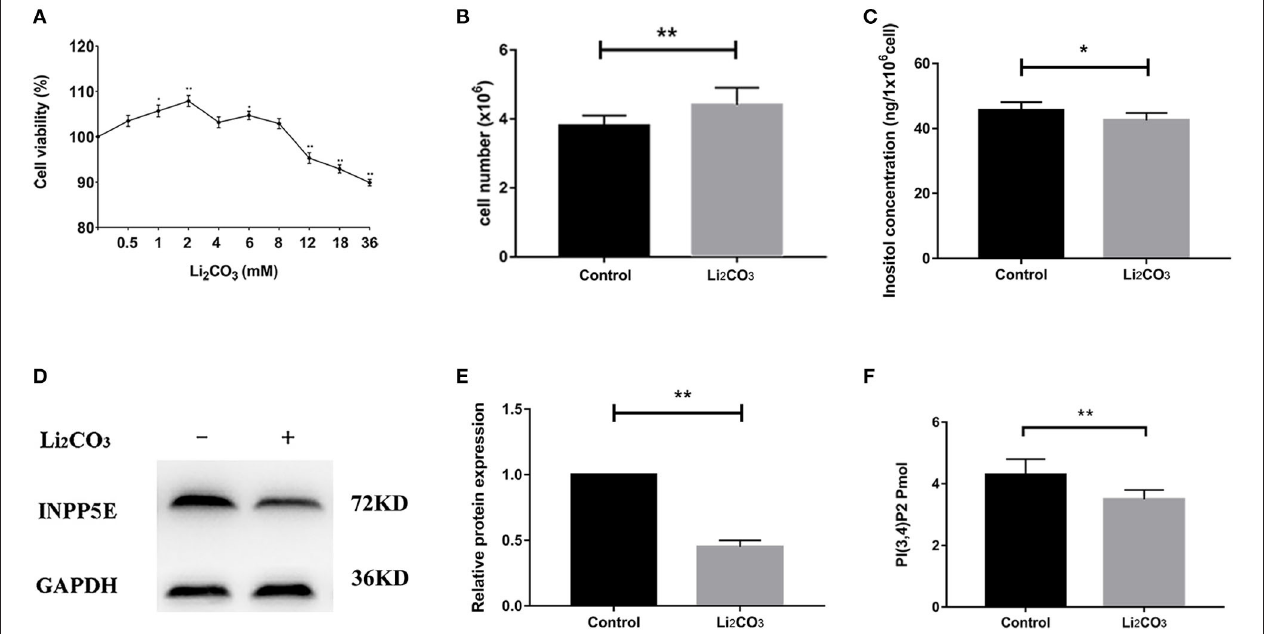
FIGURE 4 | Decreased Inpp5e expression in inositol deficiency NIH3T3 cells. (A) Cell viability of NIH3T3 cells treated with different doses of Li 2 CO 3 for 24h. (B) NIH3T3 cells treated with or without 2mM Li 2 CO 3 for 24h, and cell numbers were examined. (C) Inositol concentration was measured in NIH3T3 cells treated with or without 2mM Li 2 CO 3 for 24h. (D, E) NIH3T3 cells were treated with or without Li 2 CO 3 for 24h, and the protein expression of INPP5E were evaluated by western blot. GAPDH were used to confirm equal loading. (F) NIH3T3 cells were treated with or without 2mM Li 2 CO 3 for 24h, and PI(3,4)P2 concentration determined. All the analysis in NIH3T3 cells were performed in three independent experiments ( n = 3). Each experiment was carried out in triplicate. * P < 0.05, ** P < 0.01 vs. Control group.